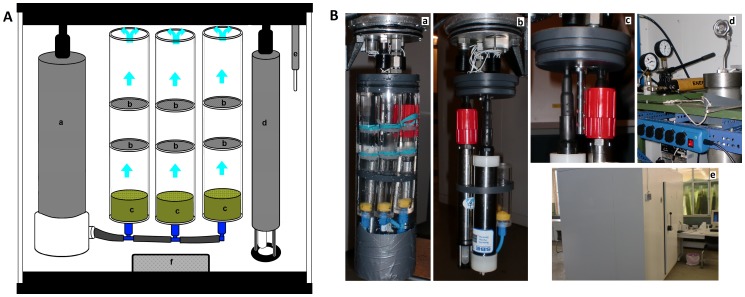
The settling microcosm used in our experiment; A: Diagram showing the components of the settling microcosm: a) pump, b) 63 µm mesh delimiting the experimental volume, c) collimators to regulate the water flow, d) p<h sensor, e) CO2 sensor, f) flexible membrane to equalize the pressure; 1 B: a) closed settling microcosm, connected to the lid of the pressure chamber, with the experimental tubes in first plan, b) detail of the settling microcosms, with the pH sensor and recirculation pump in first plan, c) detail of the settling microcosms, with the CO2 sensor in first plan, d) closed pressure chamber, e) refrigerated chamber.